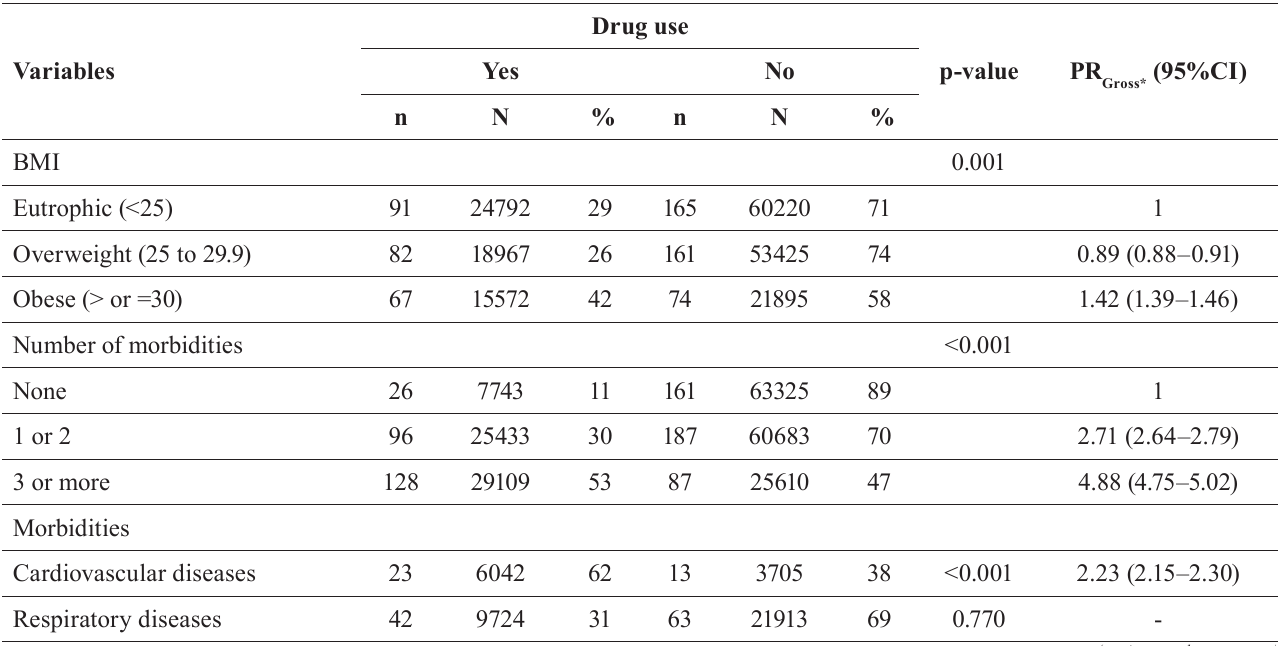
TABLE III - Prevalence and crude PR of medicine use according to health conditions of the adult population in Rio Branco, Acre, Brazil, 2014